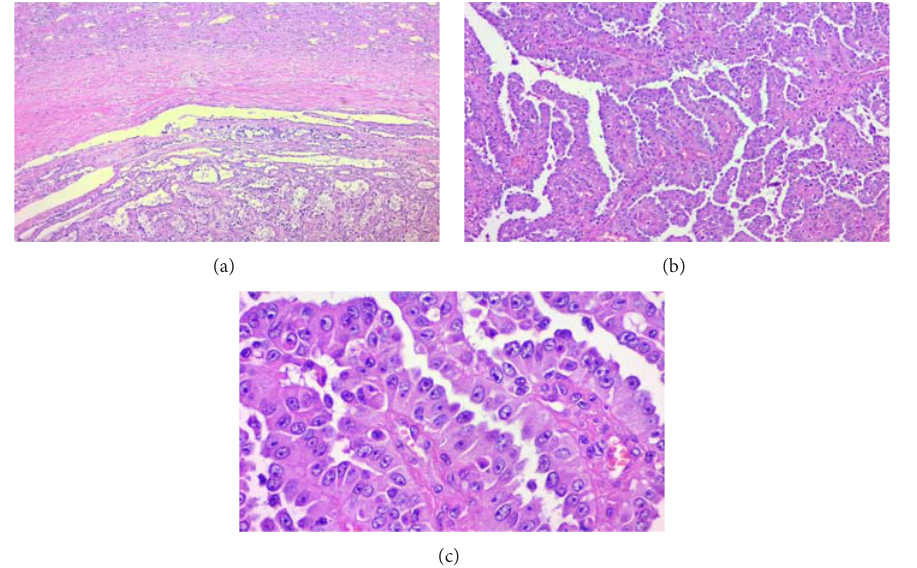
Figure 3: (a) Tumor pseudocapsule composed of fibrous tissue. H&E stain, × 50. (b) Papillae covered by large cells with abundant eosinophilic cytoplasm. H&E stain, × 100. (c) Pseudostratified high-grade nuclei with prominent nucleoli. H&E stain, × 400.